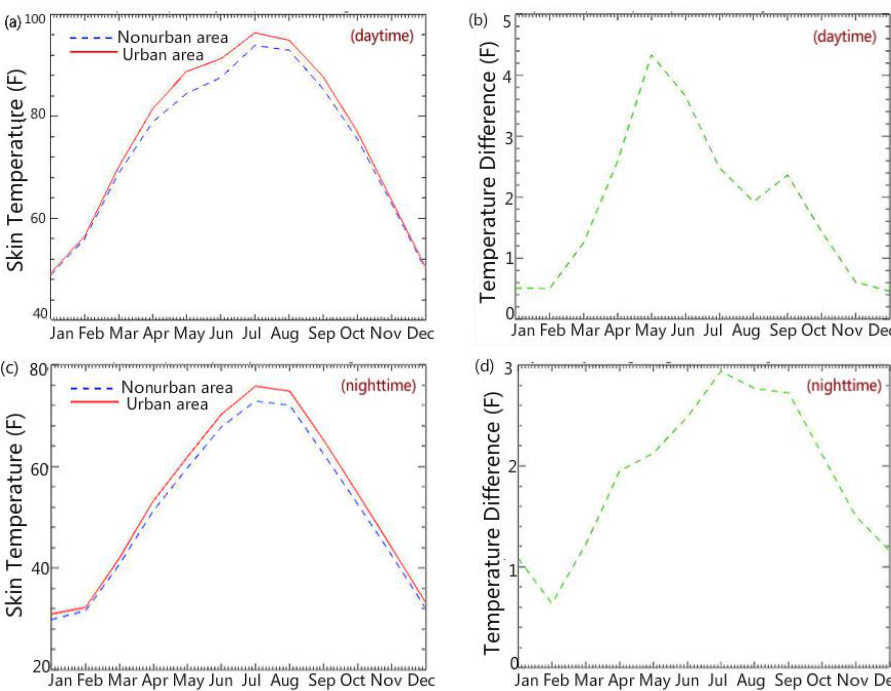
Figure 5. ( a ) OKC monthly averaged daytime skin temperature (2001–2008); ( b ) OKC monthly averaged daytime skin temperature difference (urban–nonurban); ( c ) OKC monthly averaged nighttime skin temperature (2001–2008); ( d ) OKC monthly averaged nighttime skin temperature difference (urban–nonurban). Temperature unit in °F.